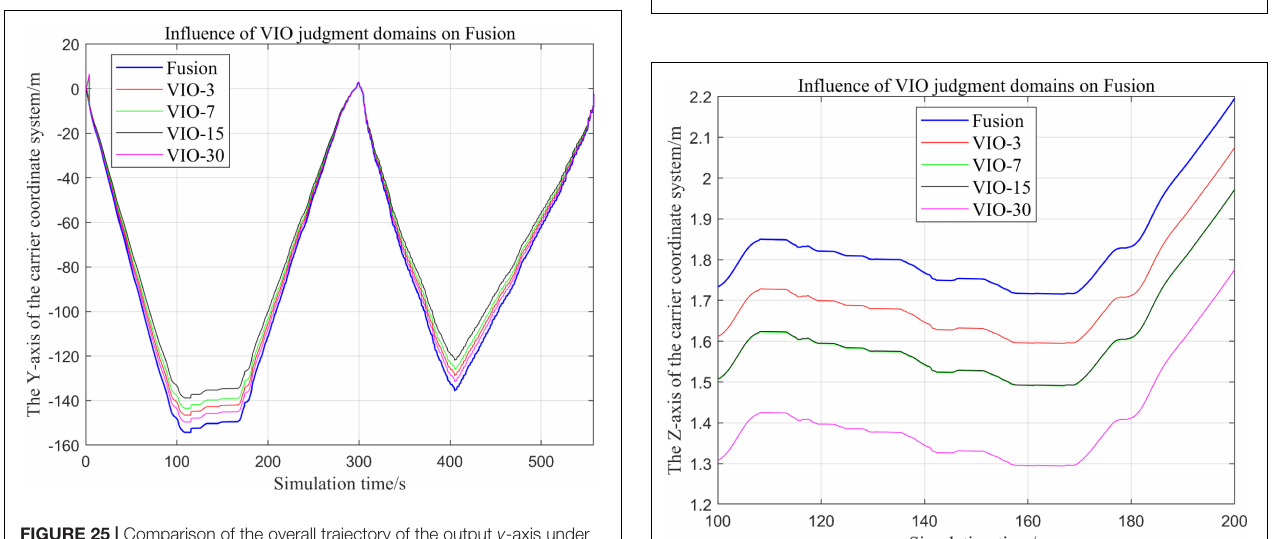
FIGURE 26 | Comparison of the overall trajectory of the output z -axis under different thresholds.